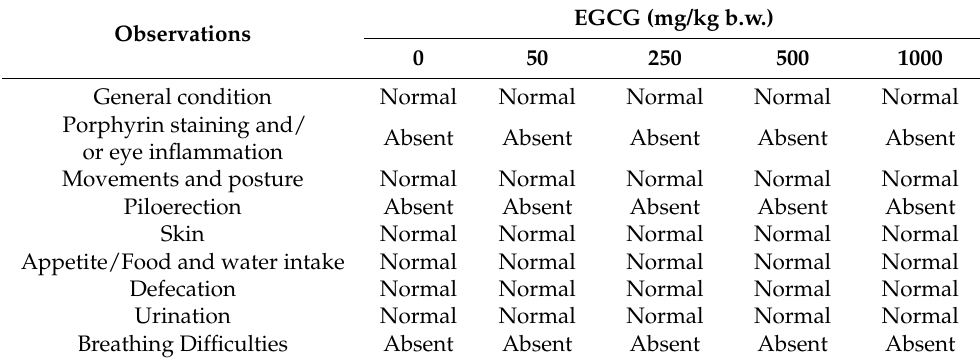
Table 4. Cage-side observation for behaviour changes and clinical signs.